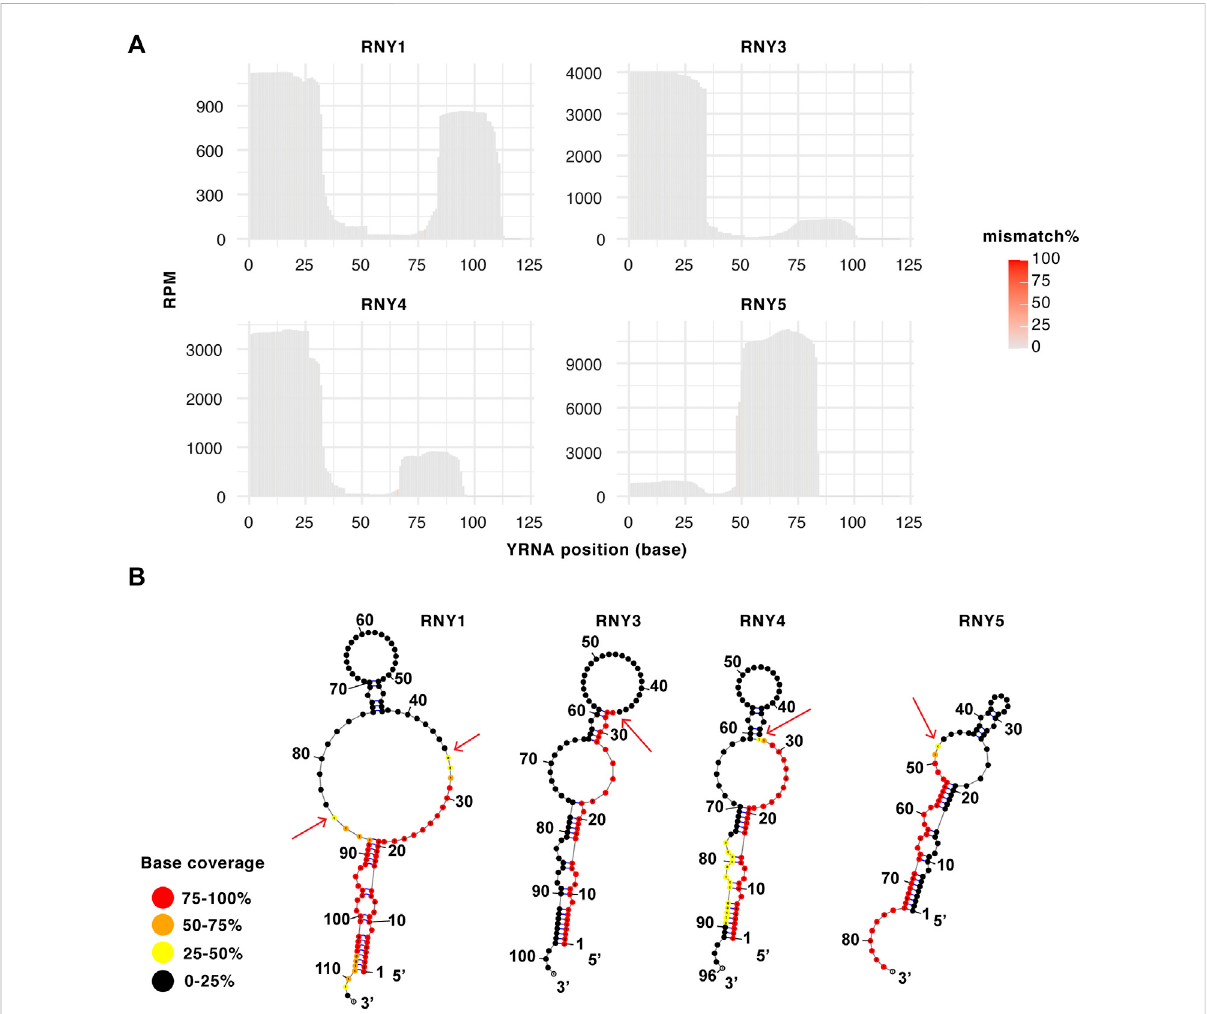
FIGURE 6 Speci fi cY-RNAfragmentswithoveralllowmismatchrate. (A) ExamplecoverageplotofYRFsmappedoneachY-RNAsequenceswithmismatch highlighted at each position (patient #1 shown as example). Coverage plots for all 12 samples are shown in Supplementary Figure S9. (B) YRF base coverage shown with Y-RNA secondary structures. Base coverage is color coded with red showing highest coverage and black showing lowest coverage. YRF cleavage site as indicated by the coverage drop is indicated by